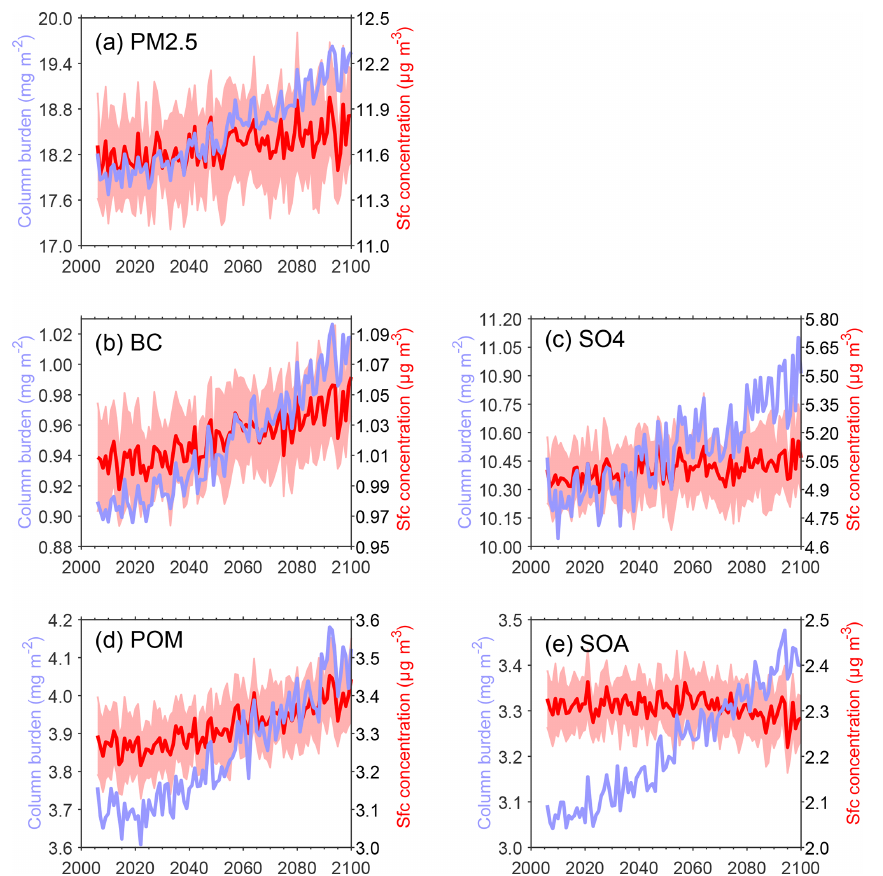
Figure 2. Plots of future changes in the total PM 2 . 5 as well as its associated species averaged over eastern China in terms of the surface concentration (µgm − 3 , right axis in red) and column burden (mgm − 2 , left axis in blue) from the simulations of the RCP8.5_FixAerosol2005 experiment. (a) PM 2 . 5 , (b) BC, (c) SO 4 , (d) POM, and (e) SOA. Ensemble variance (1 σ ) for surface concentration is shown in red